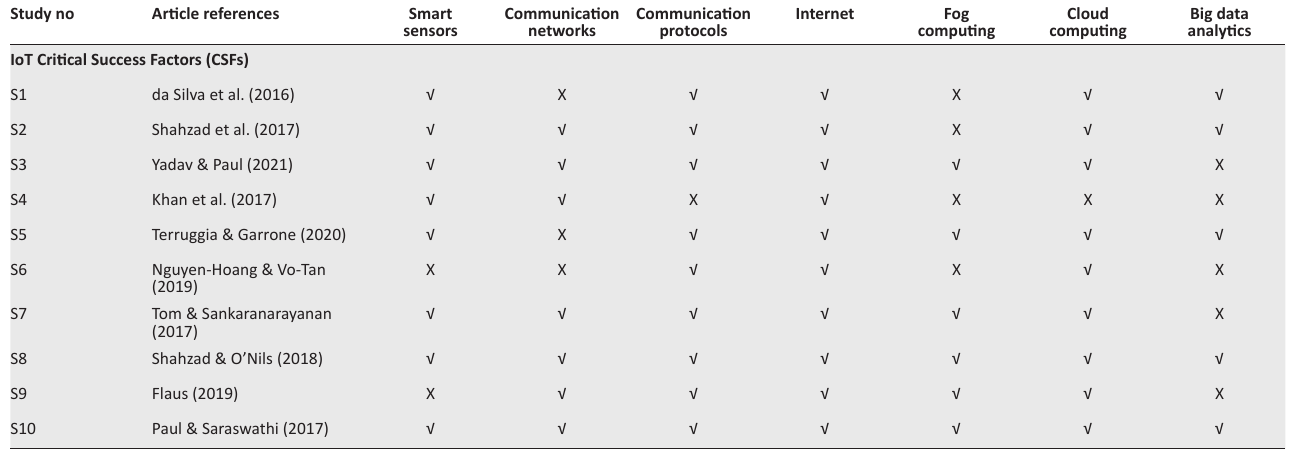
TABLE 3: The Internet-of-Things-Supervisory Control and Data Acquisition system critical success factors. Study no